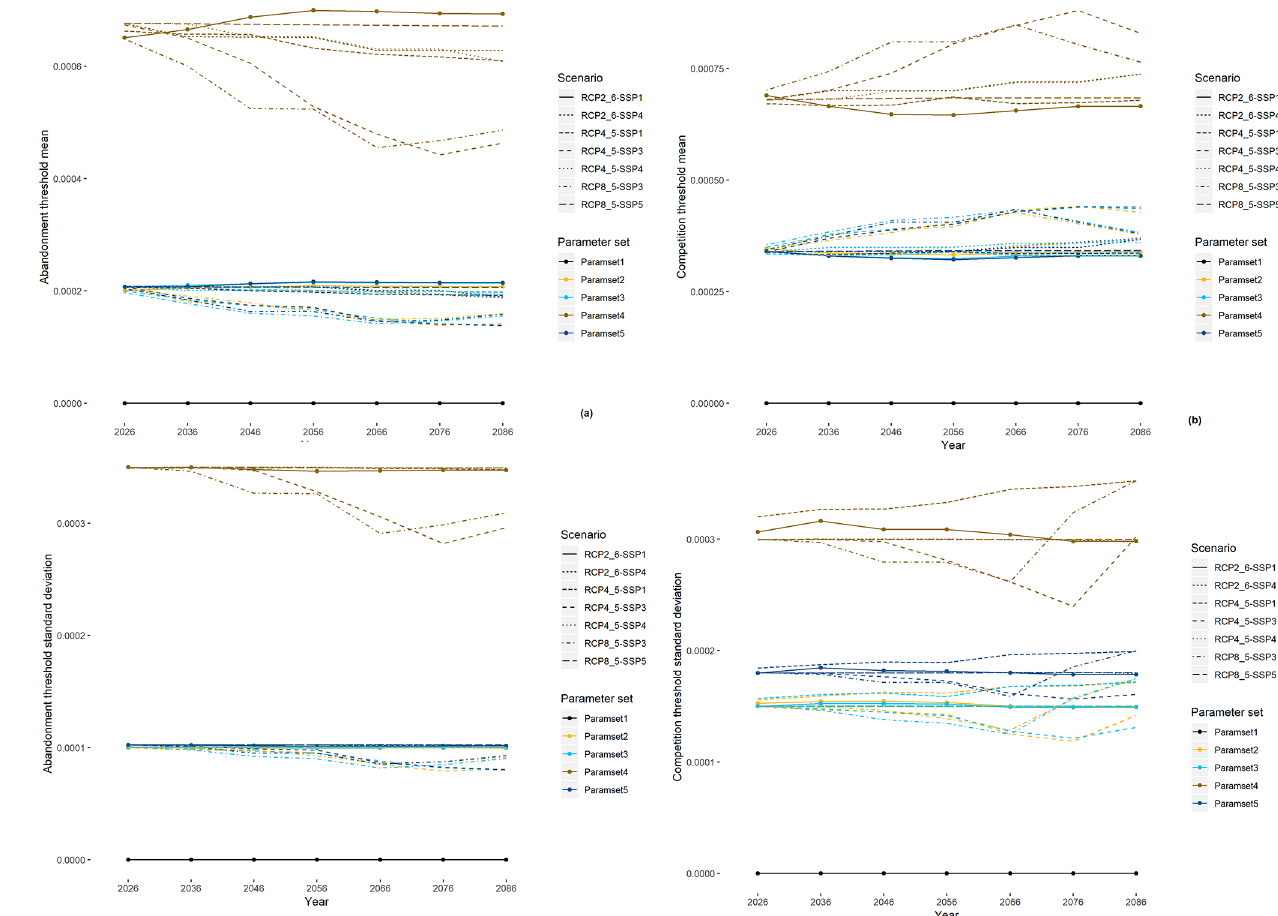
Figure C2. Behavioural parameter changes during scenario simulations: abandonment threshold means and standard deviations (a) as well as competition threshold means and standard deviations (b)